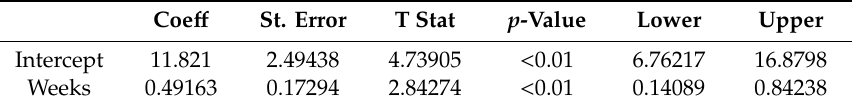
Table 4. Regression analysis.